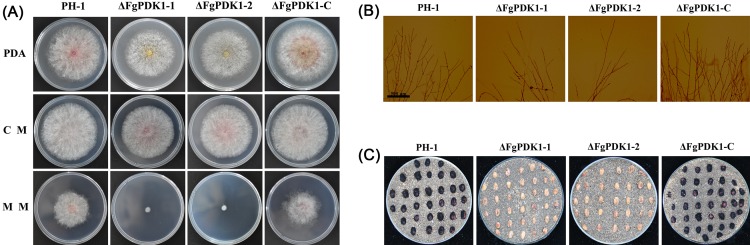
Effect of FgPDK1 deletion on F. graminearum colony morphology and perithecia production.(A) The wild-type strain (PH-1), FgPDK1 deletion mutant (ΔFgPDK1), and complemented strain (ΔFgPDK1-C) were grown on PDA, CM, and MM for 4 days at 25°C. (B) Micrographs of hyphae of PH-1, ΔFgPDK1, and ΔFgPDK1-C. (C) Black perithecia production on autoclaved wheat seeds.